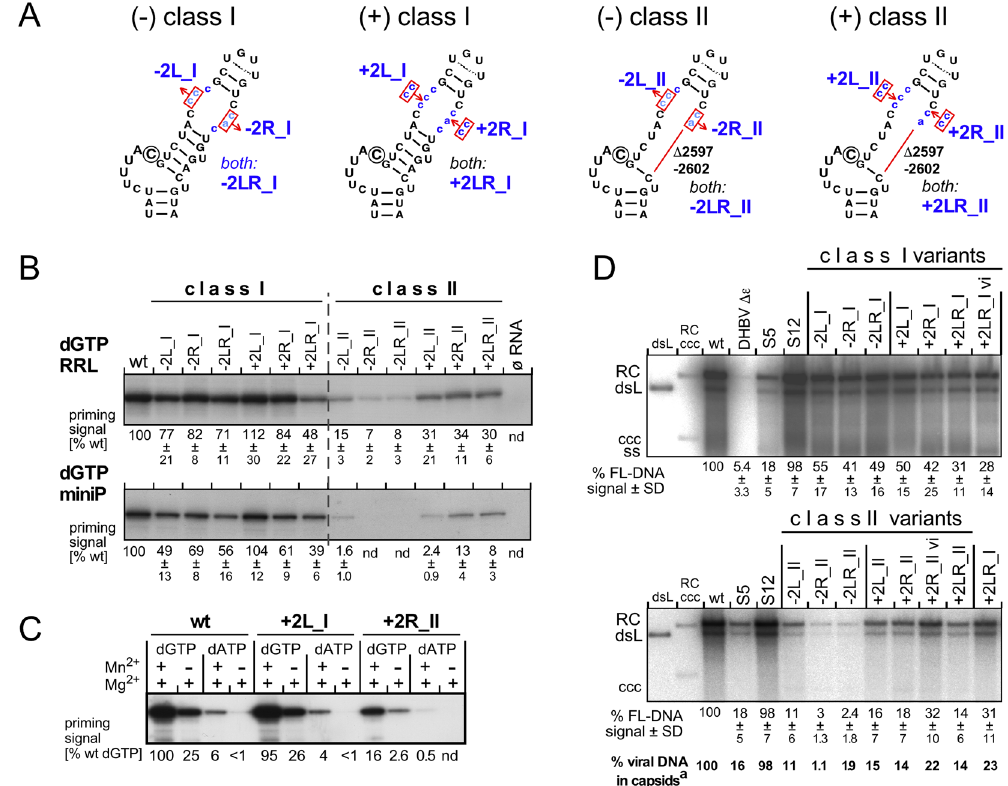
Figure 2. Interrogating a potential space-bar function of the upper D ε stem. ( A ) Sequence alterations in class I and class II variants. The distance between bulge and loop in the replication-proficient D ε variant S12 22 was altered by deleting two of its non-authentic residues on the left or right upper half-stem or both, or by analogously introducing two extra C residues on one or both sides (class I). The same changes were introduced in a variant lacking a priori six nt in the lower right half-stem (class II). The encircled C represents the dominant initiation site. ( B ) In vitro priming activities. The indicated D ε variants were in vitro transcribed and subjected to α 32 P-dGTP priming assays using full-length DHBV polymerase in rabbit reticulocyte lysate (RRL), or recombinant miniDP protein. 32 P-labeled P protein was visualized, after SDS-PAGE, by autoradiography. Signal intensities were quantified by phosphorimaging; numbers below each lane show the mean relative priming signals ± standard deviation (SD; n ≥ 3) compared to wt D ε RNA which was set to 100%; nd, not detectable. Analogous data for α 32 P-dATP are shown in Supplementary Fig. S1. ( C ) No impact of typical class I and class II mutations on dNTP specificity during in vitro priming. MiniDP priming assays were performed using either α 32 P-dGTP or α 32 P-dATP in the presence of only Mg 2 + , or Mg 2 + plus Mn 2 + . In either constellation, dGTP was incorporated ~20-fold more efficiently than dATP. ( D ) Class I and class II variants support viral replication. LMH cells were transfected with pCD16 vectors bearing the indicated mutant sequences in both 5 ′ and 3 ′ D ε . Vectors encoding wt-DHBV16 (wt), a variant defective in 5 ′ D ε (DHBV Δε ), and the upper stem variants S5 and S12 22, 30 served as controls. DNA from cytoplasmic nucleocapsids was analyzed by Southern blotting using a 32 P-labeled DHBV DNA probe. Numbers indicate mean signal intensities ± SD (n ≥ 3) of full-length DNAs (RC + dsL) relative to wt-DHBV which was set to